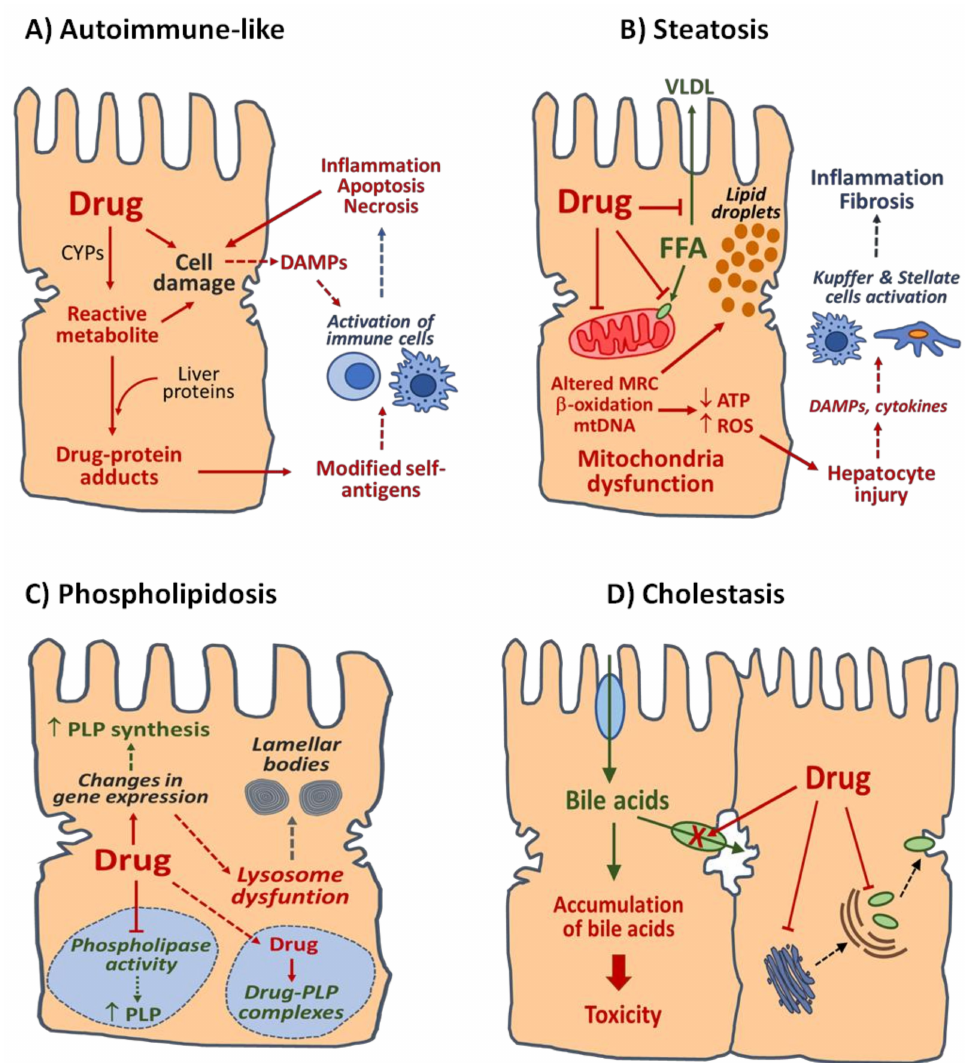
Figure 1. Mechanisms of four main types of DILI . ( A ) Autoimmune-like DILI . Reactive metabo- lites generated by CYPs and other drug-metabolizing enzymes can covalently bind liver proteins and form drug-modified self-antigens recognized by immune cells. Release of damage associated molecular patterns (DAMPs) resulting from hepatocyte stress induced by parental drug or their reactive metabolites can also contribute to the activation of immune cells. ( B ) Steatosis . Drugs may alter fatty acid (FFA) homeostasis in the liver by several mechanisms, including the reduction in FFA export as very low-density lipoproteins (VLDL), impairment of FFA entry in the mitochondria, direct inhibition of mitochondrial β -oxidation enzymes, disruption of mitochondrial respiratory chain (MRC) or depletion of mitochondrial DNA (mtDNA). Non-metabolized FFA are esterified to form triglycerides and accumulate in the cytoplasm of hepatocytes as lipid droplets. Drug-induced mitochondrial dysfunction can result in ATP depletion and increased formation of reactive oxygen species (ROS) and subsequent hepatocyte injury. Further activation of Kupffer and stellate cells by DAMPs and/or cytokines released by damaged hepatocytes may induce inflammatory and